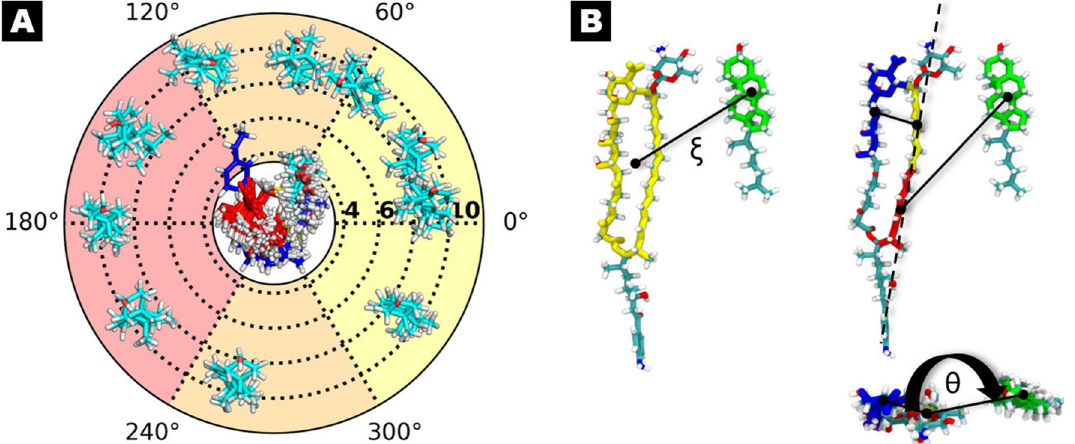
Figure 2. Panel ( A ): dihedral angle θ, defining position of a sterol molecule concerning specific regions of an antibiotic molecule: polyene region (yellow colour, angles 0–60° and 300–360°), in between (orange colour, angles 60–120° and 240–300°) and polyol region (red colour, angle 120–240°). Panel ( B ): a schematic depiction of the reaction coordinates (ξ, θ) used to define the relative position of the sterol and antibiotic